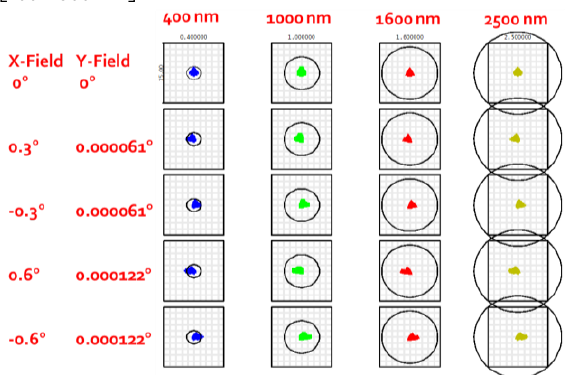
Figure 6. Resulting matrix spot diagram of the TMA telescope design (black circles represent Airy disk, black squares represent 15 μm square pixel)